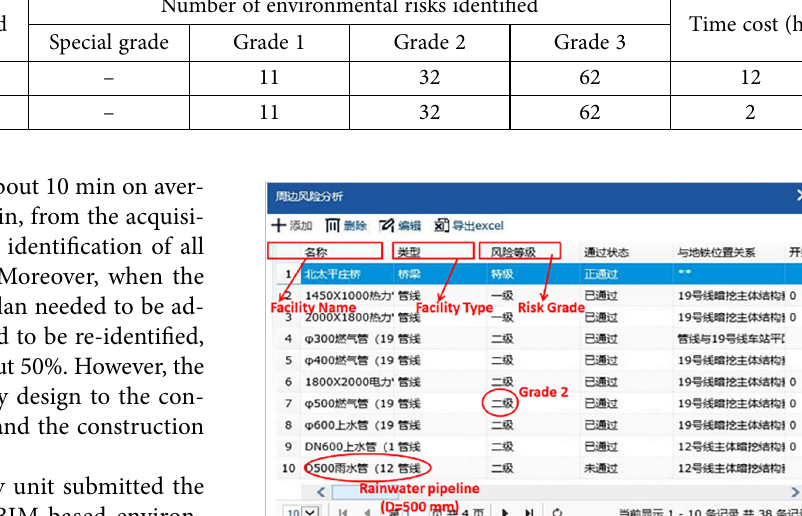
Table 6. Comparison of the environmental risk identification results Identification and classification method